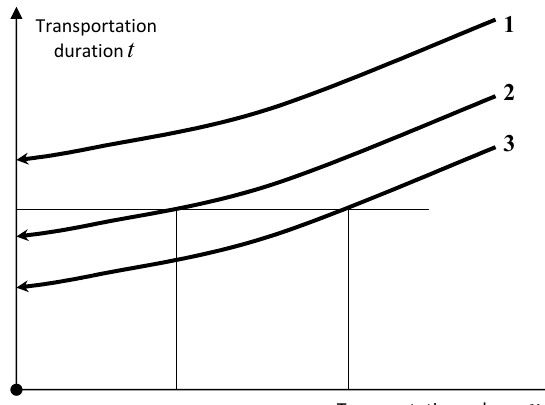
Fig. 3: Options of the dependence of transportation durations on freight volumes